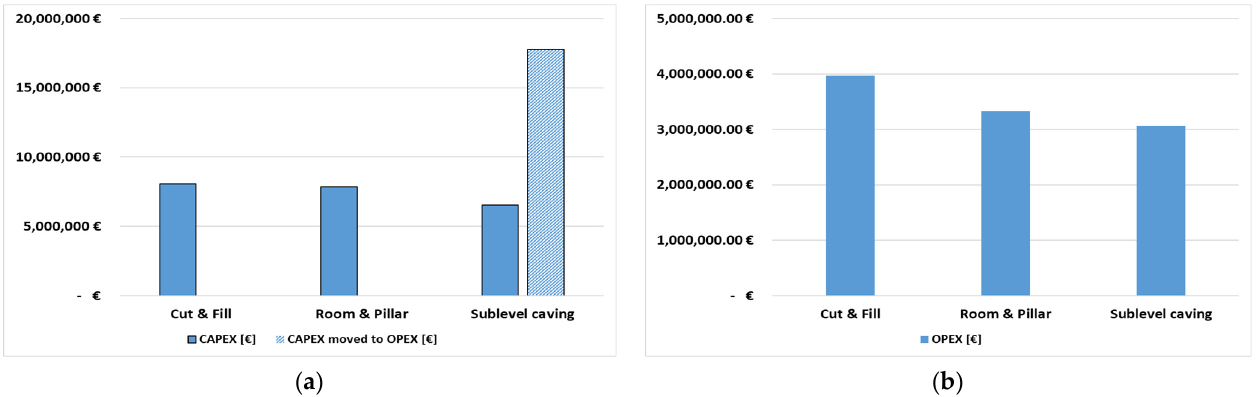
Figure 4. ( a ) CAPEX and ( b ) Yearly OPEX estimation for each of the underground mining scenarios.